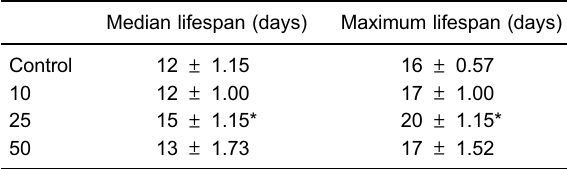
Data are reported as means ± SD. Aging assays were performed at 20°C except for daf-2 , which was carried out at 16°C. Experiments were repeated three times starting with 90 nema- todes per group. *P o 0.05, signi fi cantly different from untreated control group by the log-rank (Mantel-Cox)